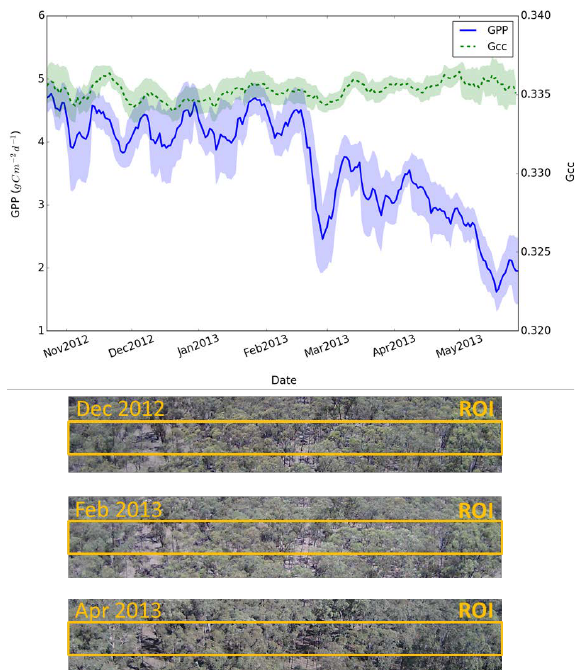
Figure 7. Ecosystem gross primary productivity (GPP) and green chromatic coordinate (GCC) index for the Whroo dry temperate OzFlux site (Fig. 2; site 6, AU-Whr) in south-eastern Victoria, Aus- tralia. Both GPP and GCC data are shown by an 8-day centred run- ning mean with ± 90% confidence shading. The region of interest (ROI) for GCC calculation is indicated by the orange box in the three images that represent different times throughout the